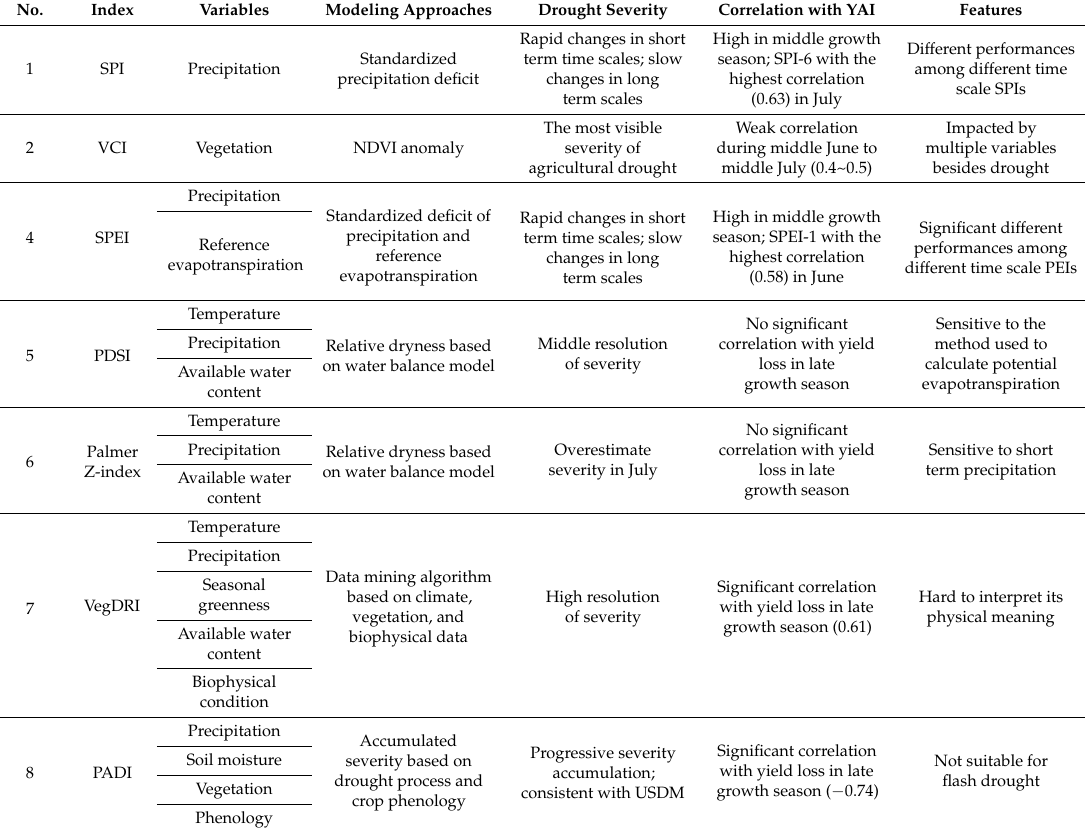
Table 7. Comprehensive comparison between PADI and other drought